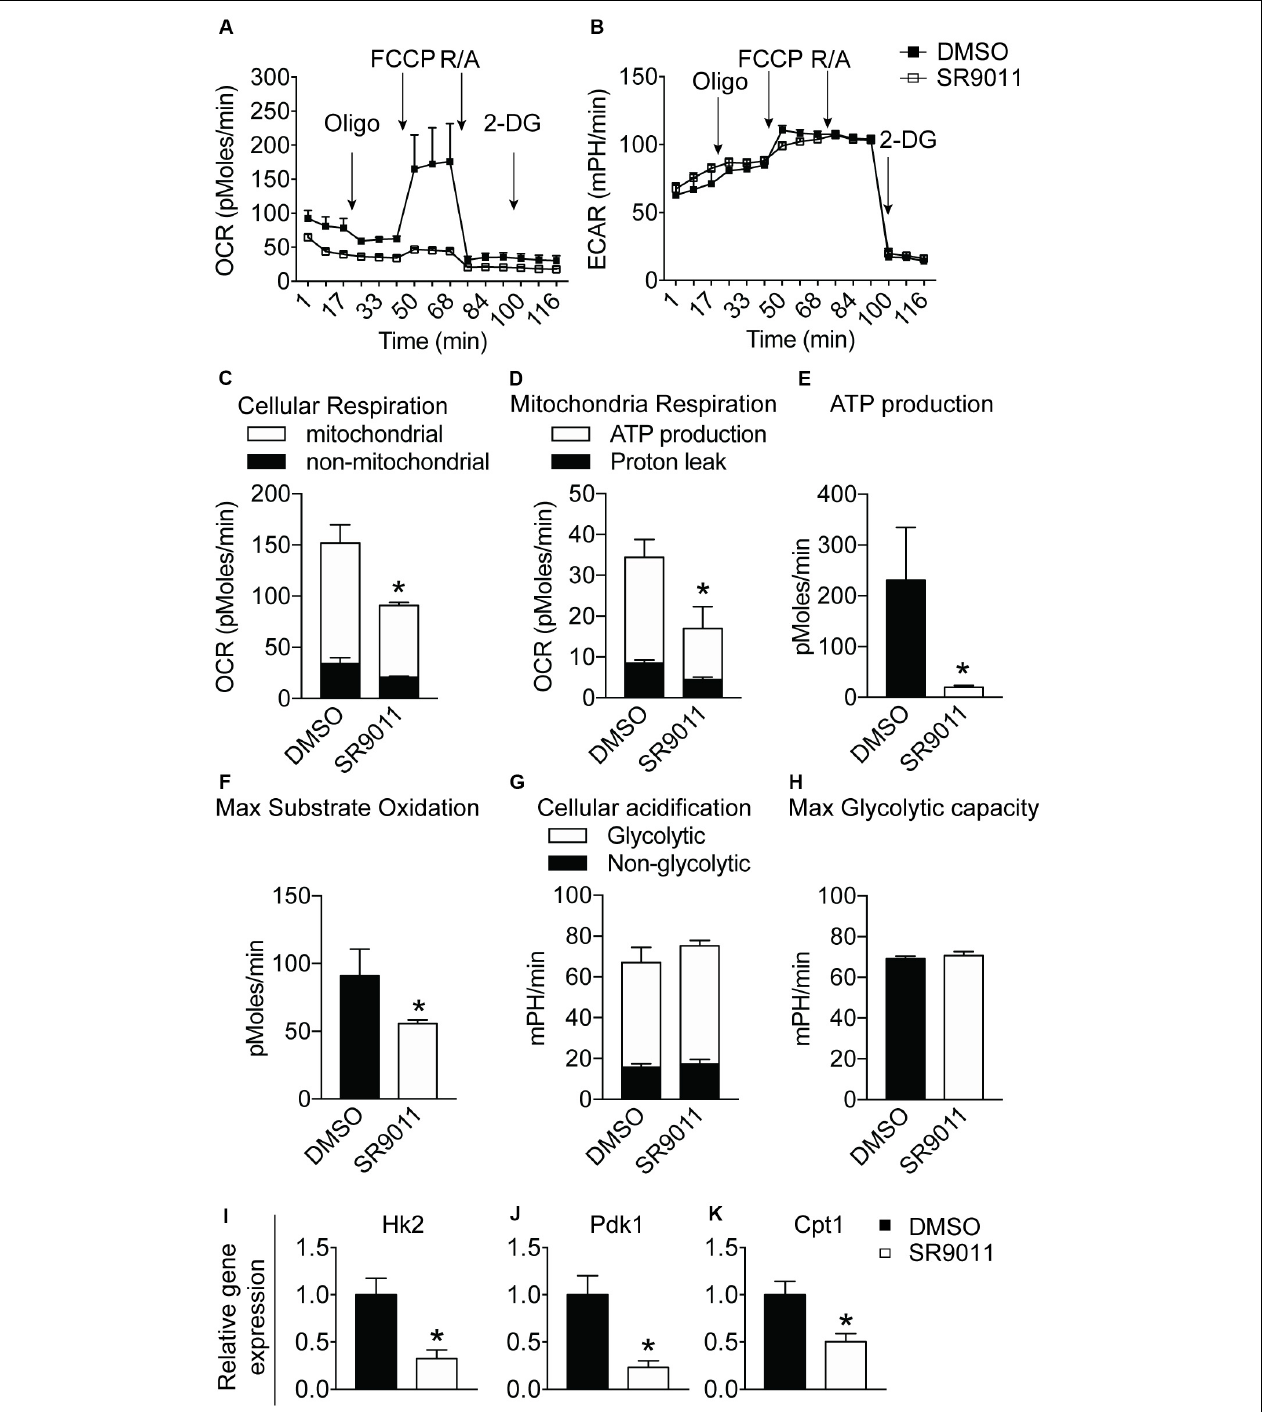
FIGURE 6 | The effect of SR9011 on cellular metabolism in primary microglia. Cellular bioenergetics and metabolic gene expression in primary microglia after SR9011 treatment ( n = 4 per group). (A, B) Overview of OCR (A) and ECAR (B) of primary microglia treated with DMSO or SR9011 for 12 h. Indicated are the times on which oligomycin, FCCP, rotenone/antimycin A (R/A) and 2DG were administered. (C–H) SR9011 decreased cellular respiration (C) , which was caused by a decline in ATP-linked mitochondrial respiration (D) . Consequently, ATP production was significantly decreased in response to SR9011 (E) . SR9011 also caused a decrease in maximum substrate oxidation (F) . No changes were found in cellular acidification (G) and maximum glycolytic capacity (H) . (I–K) SR9011 decreased the expression of metabolic genes Hk2 (I) , Pdk1 (J) , and Cpt1 (K) in primary microglia treated by dexamethasone for 2 h and SR9011 for 6 h. Data are presented as means ± SEM and statistical significance was determined using Unpaired t -test in all experiments. p < 0.05*.